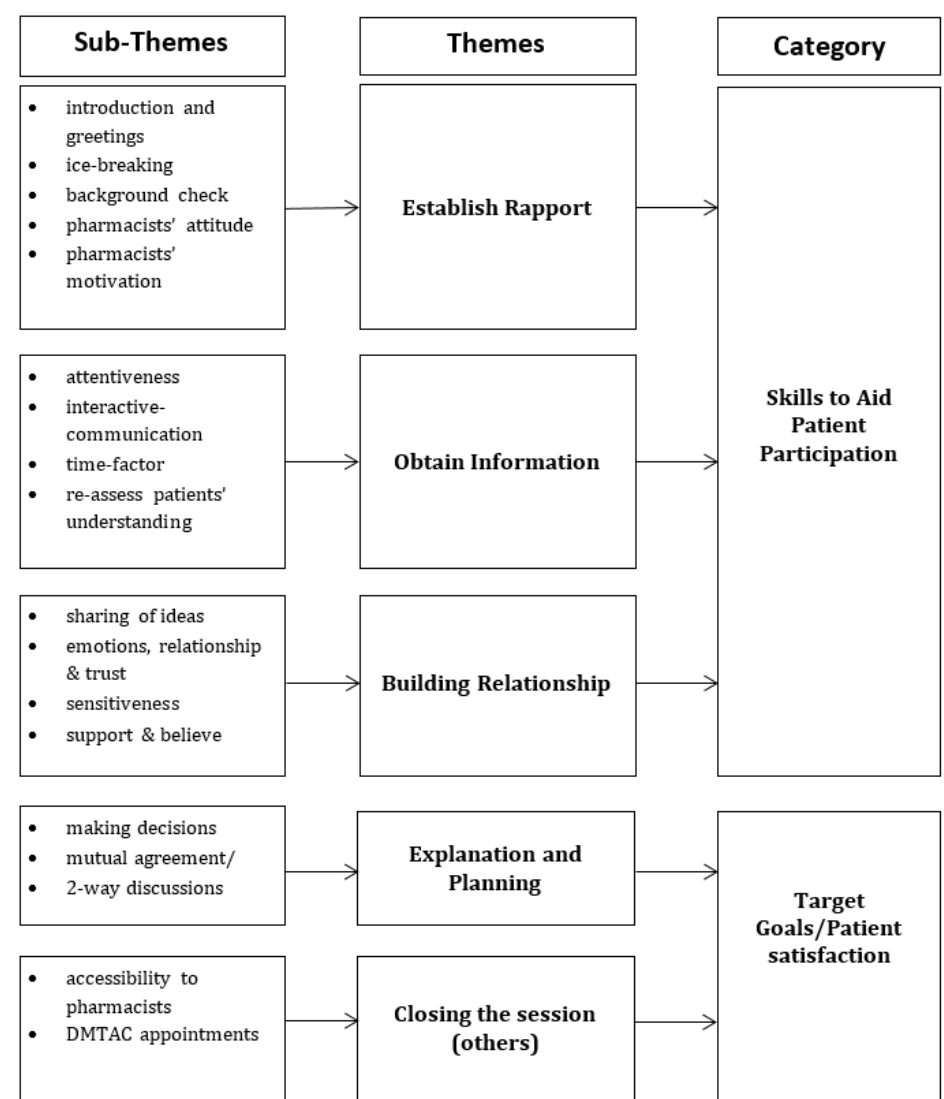
Figure 1: Conceptual framework of pharmacist active engagement in diabetic